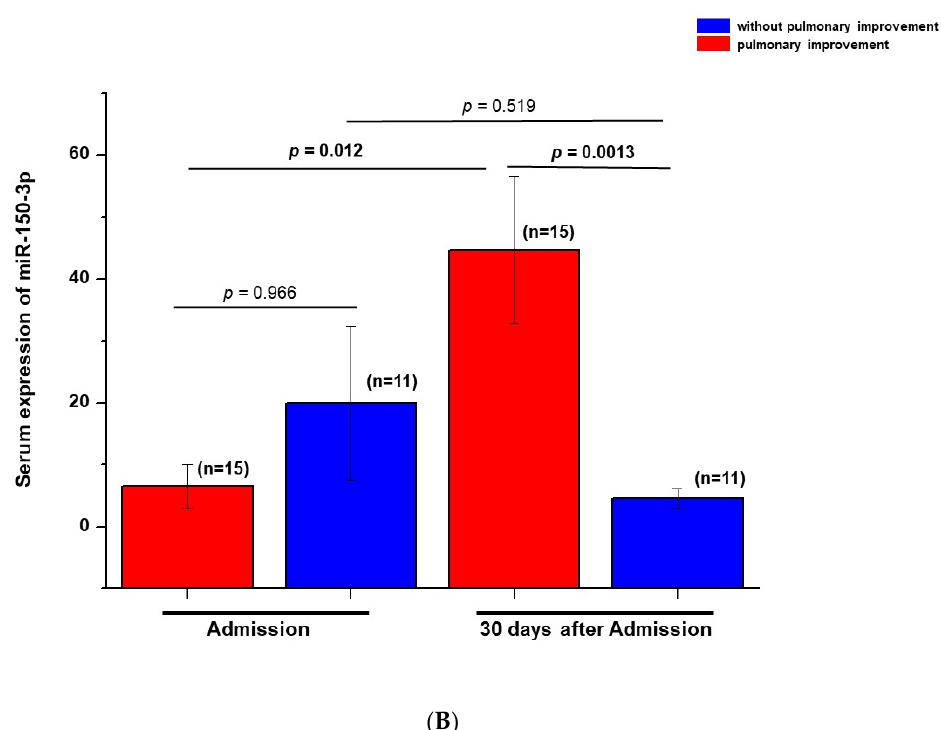
Figure 4. ( A ). Validation of OpenArray miR ‐ 150 ‐ 3p results by qRT ‐ PCR using serum samples ob ‐ tained at 30 days after hospital admission. The Mann–Whitney two ‐ tailed U test was used to com ‐ pare groups. ( B ). Comparison by qRT ‐ PCR of the serum expression of miR ‐ 150 ‐ 3p in samples from patients with COVID ‐ 19 at admission and 30 days after hospital admission. The Kruskal–Wallis test followed by the Wilcoxon test was used to compare